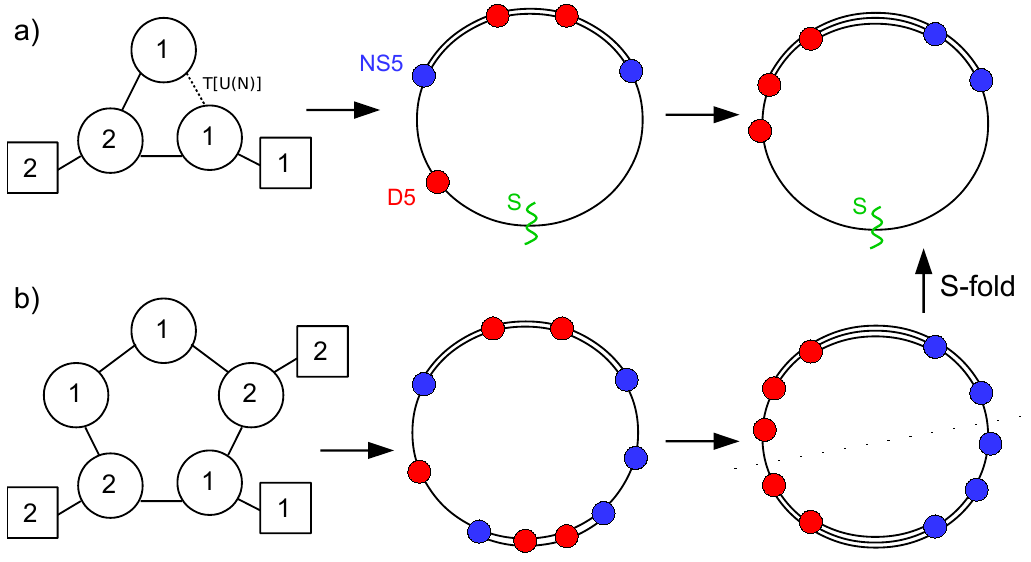
Figure 8 . An example of S -folding. The resulting S-(cid:13)ip solution has an S monodromy cut (green dashed